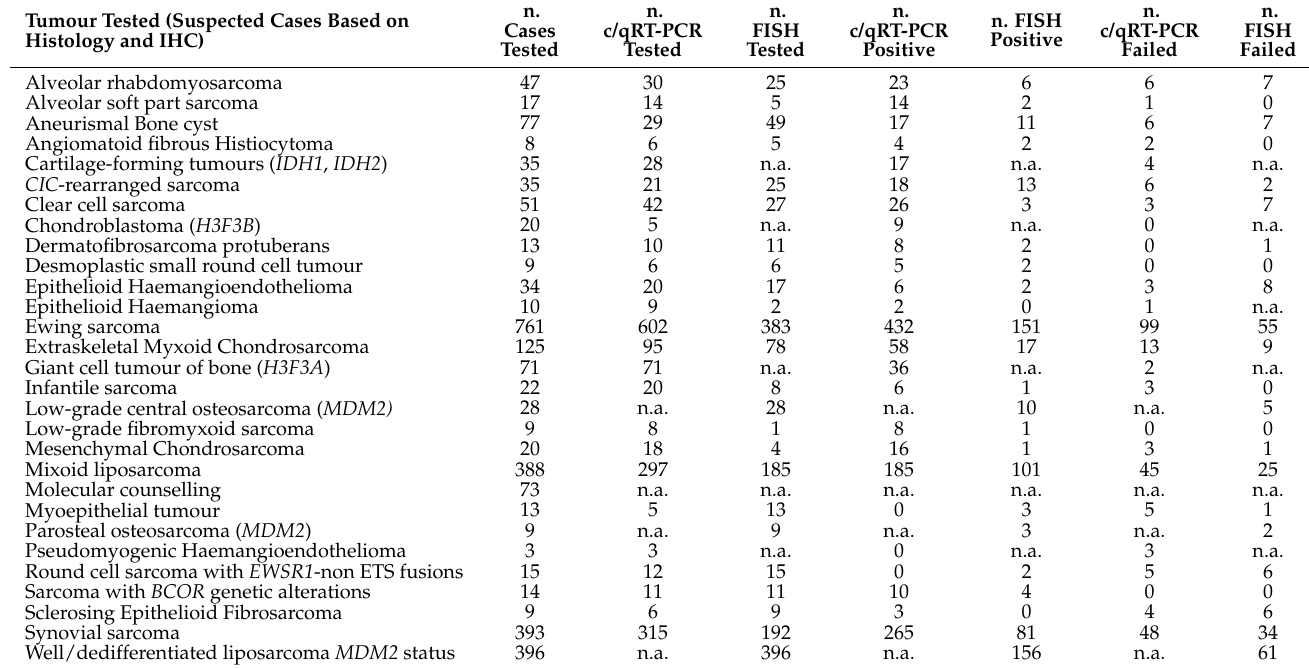
Table 1. Tumours tested for molecular diagnostic confirmation with total positive findings by c/qRT- PCR and FISH.